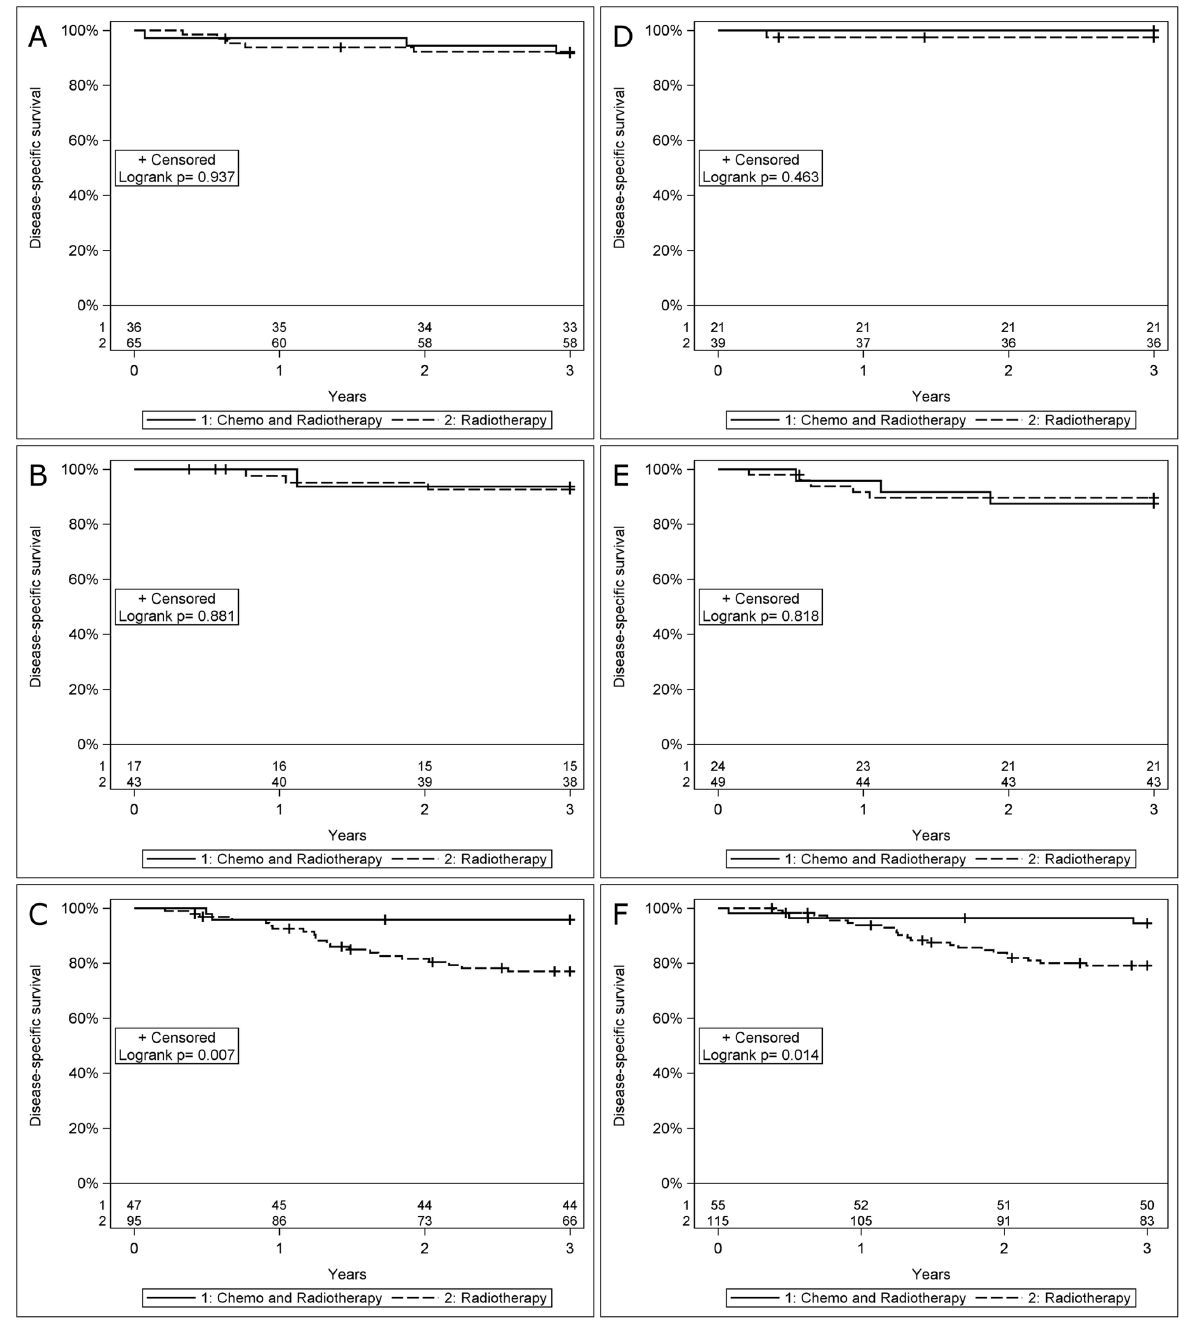
Figure 2. Survival presented with Kaplan-Meier curves, and analyzed using the logrank test, for disease-specific survival (DSS) in patients with HPV-positive oropharyngeal squamous cell carcinoma (HPV + OSCC) with known HLA class I DNA intensity and different treatment regimes. (A) DSS in HPV + OSCC with absent HCA-2 intensity stratified for radiotherapy DNA (RT) and induction chemotherapy-RT, (B) DSS in HPV + OSCC with weak HCA-2 intensity stratified for radiotherapy (RT) and DNA induction chemotherapy-RT, (C) DSS in HPV + OSCC with strong HCA-2 intensity stratified for radiotherapy (RT) and induction DNA chemotherapy-RT, (D) DSS in HPV + OSCC with absent HC-10 intensity stratified for radiotherapy (RT) and induction DNA chemotherapy-RT, (E) DSS in HPV + OSCC with weak HC-10 intensity stratified for radiotherapy (RT) and induction DNA chemotherapy-RT, (F) DSS in HPV + OSCC with strong HC-10 intensity stratified for radiotherapy (RT) and induction DNA chemotherapy-RT. doi: 10.1371/journal.pone.0077025.g002 PLOS ONE |